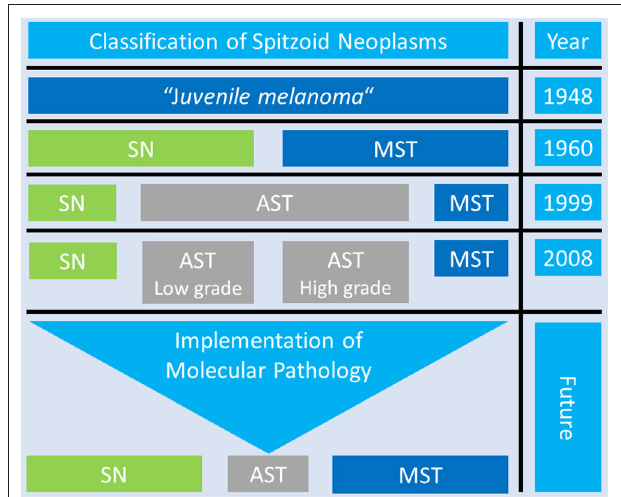
FIGURE 5 | Overview of the Classification Systems of Spitzoid Neoplasms. Over time there have been many different diagnostic approaches to classify Spitzoid neoplasms. The proposed three- and four- tiered classification system best reflect the existence of the group op ambiguous Spitzoid neoplasms with atypical Spitz tumor (AST, gray color) with intermediate features in between complete benign Spitz nevi (SN, green color) and clear cut malignant Spitz melanoma, i.e., malignant Spitz tumor (MST, blue color). The application of ancillary diagnostic techniques and implementation of findings from molecular pathology might help to reduce the uncertain diagnostic category of AST to a minimum and improve and clarify patient management in the